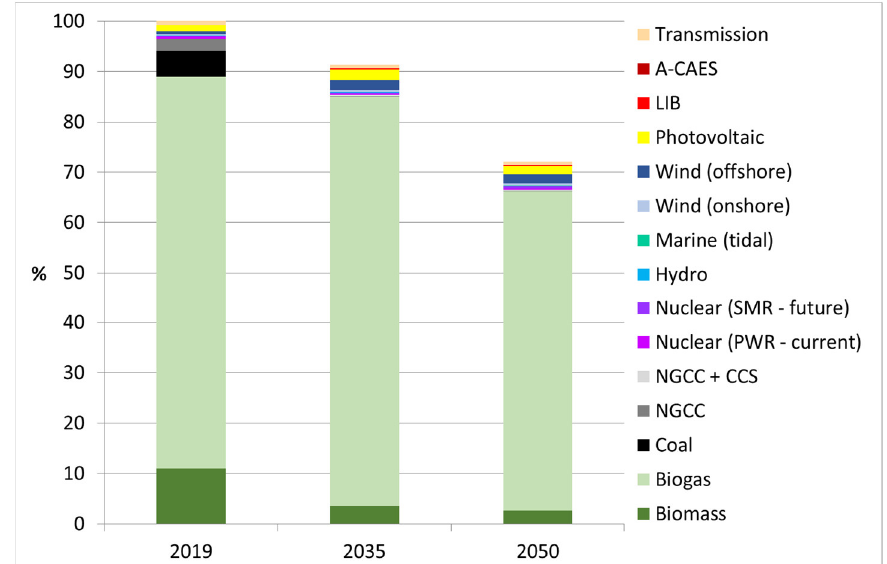
Figure 9. Acidification potential per unit of electricity delivered by the UK grid mix (including energy storage and transmission), expressed as relative to the 2019 value (100% = 2.1 g SO 2 -eq/kWh).